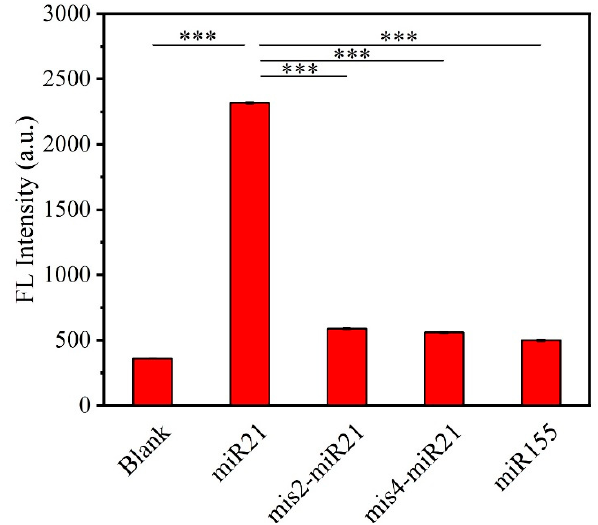
Figure 3. Selectivity and specificity analysis of dsDNA probe. The fluorescence intensity of dsDNA probe (100 nM) supplemented with buffer (Blank), miR21, two-base-mismatched (mis-2-miR21), four-base-mismatched (mis-4-miR21) and miR155 RNAs. Results represent mean ± SD (n = 3). Statistical difference, *** p < 0.001.